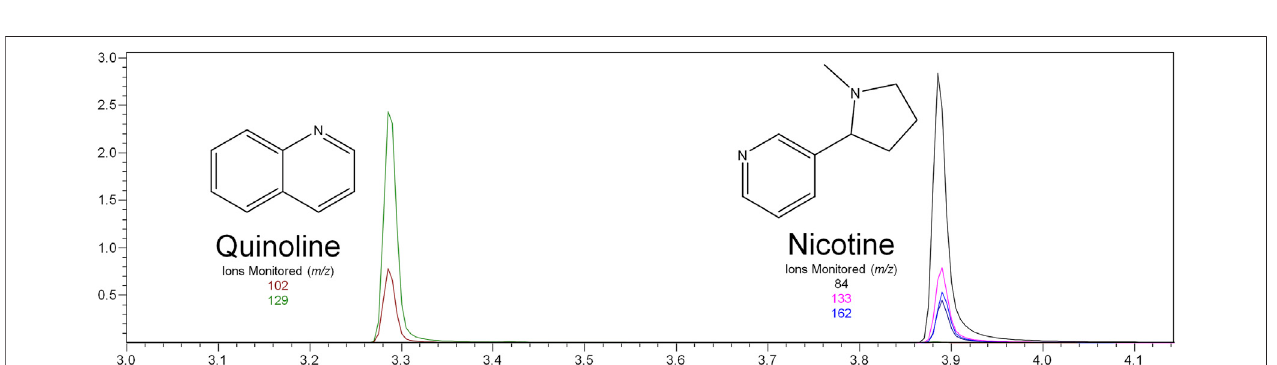
FIGURE 1 | GC-MS chromatogram produced from nicotine standard (S6 – 500 μ g/ml), with structures and ions monitored for nicotine and quinoline.